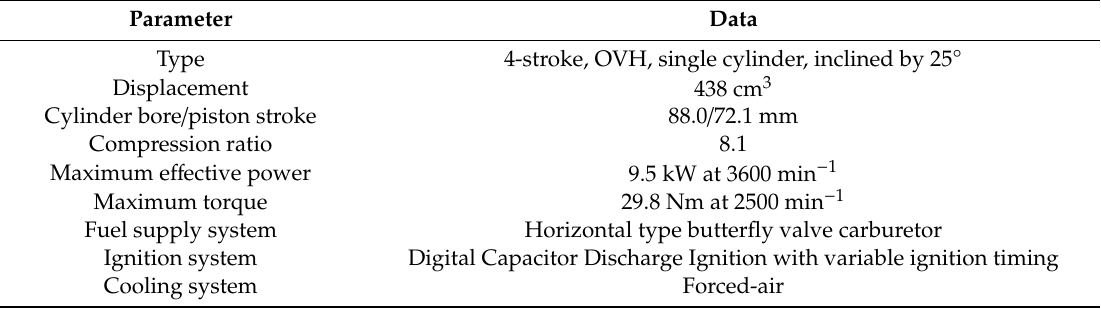
Figure 2. Schematic diagram of laboratory test stand used in the empirical work. Table 1. Specifications of the Honda IGX440 engine.